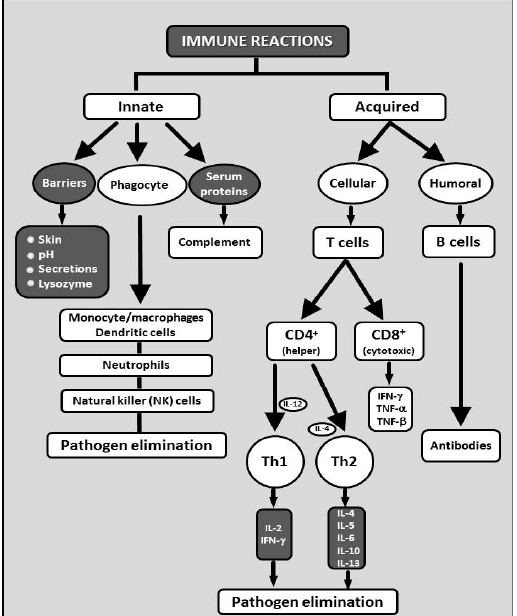
Figure 1. Various aspects of the both branches of immune reactions. Reaction known to be influenced by glucan are represented in white, reactions where glucan has no confirmed effects are shown in black.